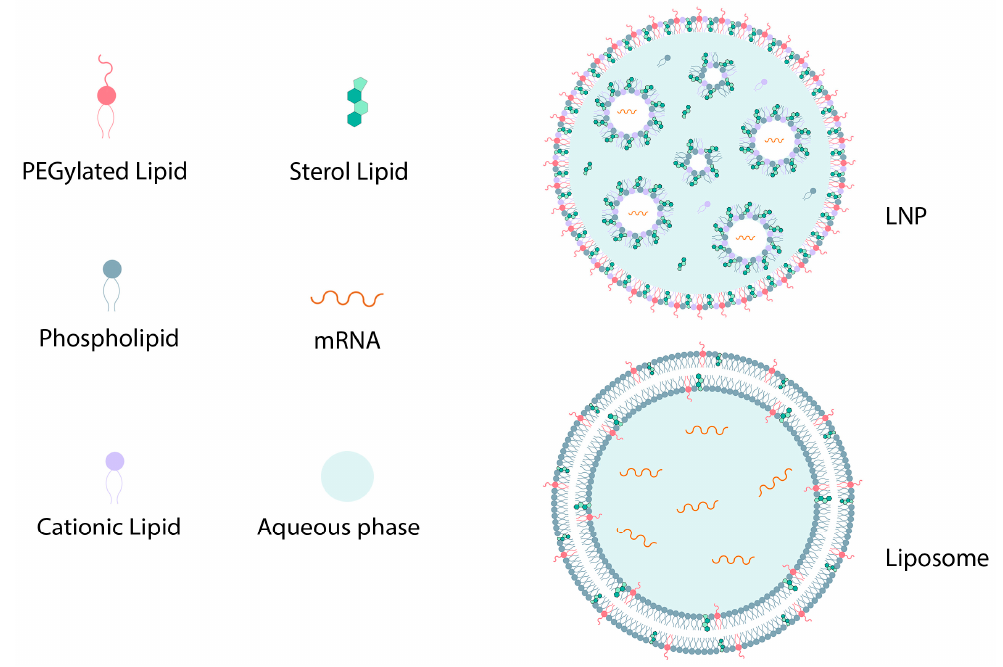
Figure 4. The general structure of an LNP and liposome.